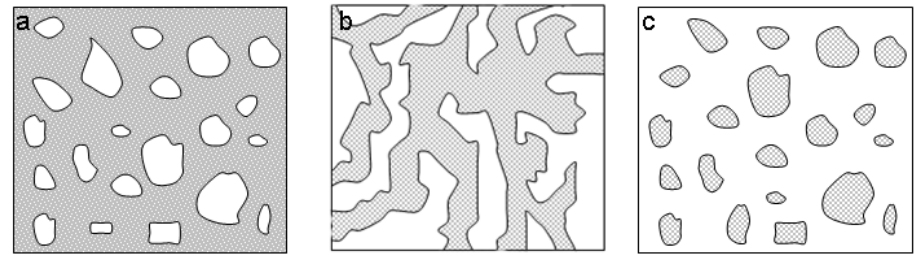
Figure 2. Different types of morphology which occur during coarsening of various starting